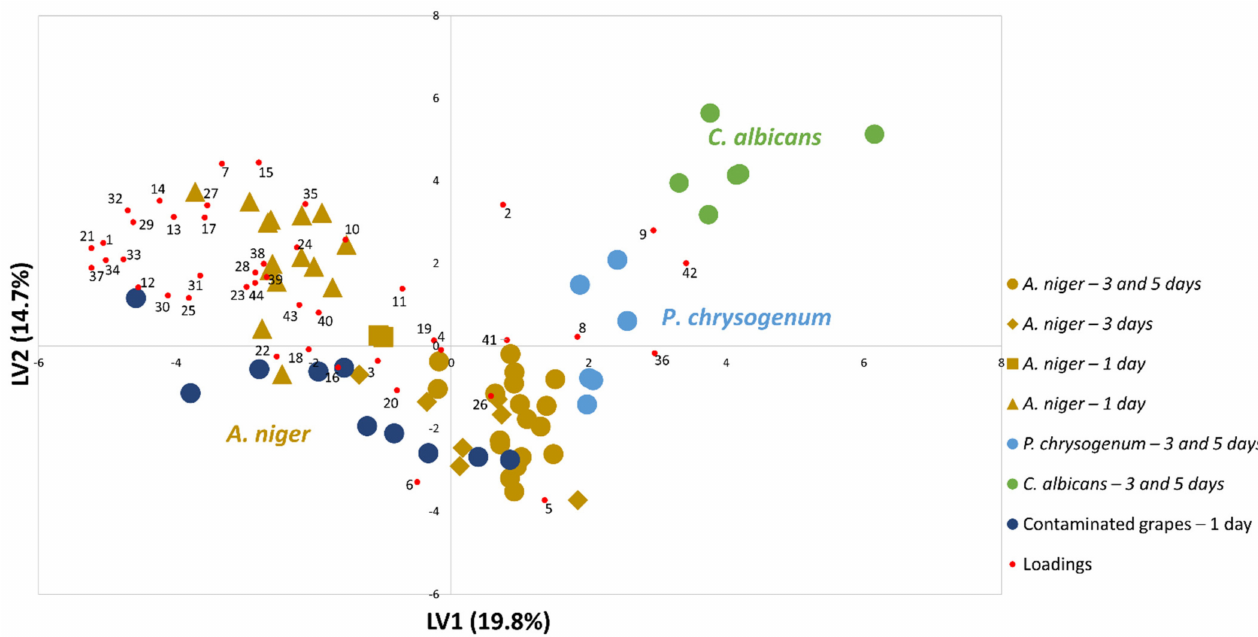
Figure 4. PLS-DA biplot of samples (LV1 × LV2) using the set of 44 metabolites listed in Table 1, which shows that the grapes contaminated with A. niger presents a metabolomics pattern like the pure cultures. The areas were previously standardized by CFU mL − 1 (Table S1). Results obtained by performing the pure culture growth in solid YGC A culture medium and by contaminated grapes (Red Globe and Dominga) with A. niger